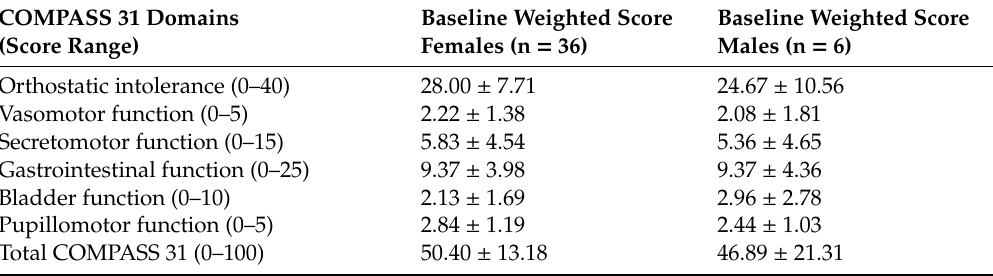
Table 4. COMPASS 31 weighted scores at baseline according to gender.